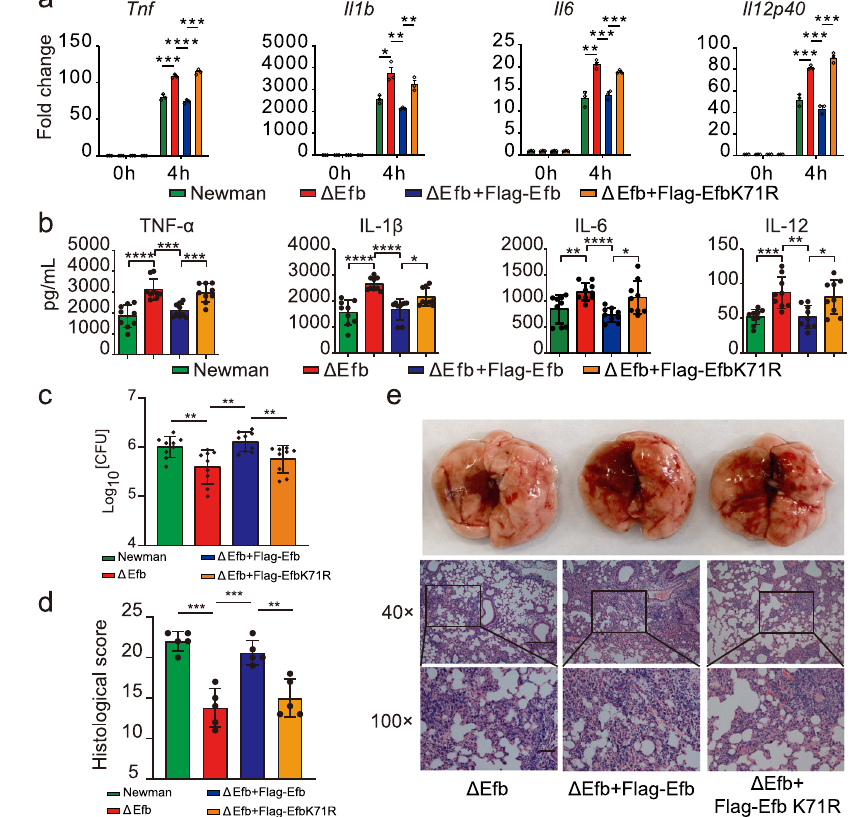
Fig. 6 | Efb inhibits host immunity depending on K27-ubiquitination. a qPCR analysis of Tnf , Il1b , Il6 , and Il12p40 mRNA from PMs infected with Newman, Δ Efb, Δ Efb+ Flag − Efb, or Δ Efb +Flag − Efb K71R for indicated times(MOI= 25; *** P = 0.0001, **** P <0.0001, *** P = 0.0004, in sequence, Tnf